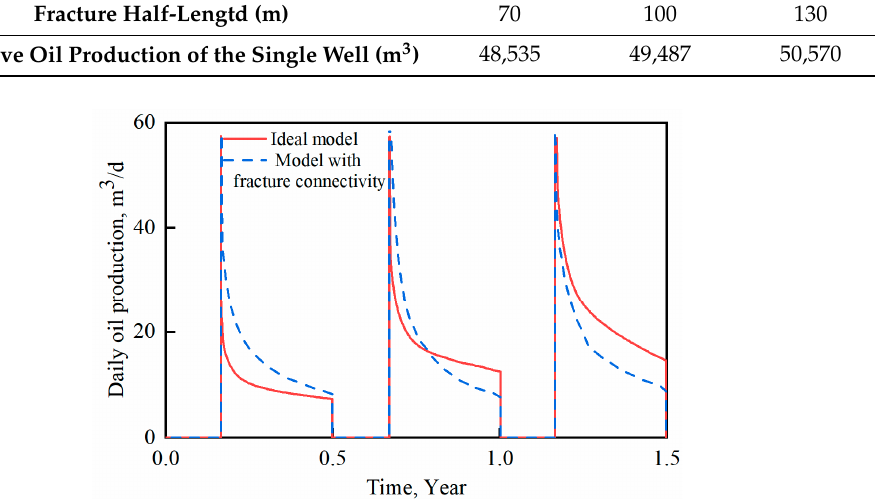
Figure 17. Comparison of daily oil production of the single well between the ideal model and the model with fracture connectivity.